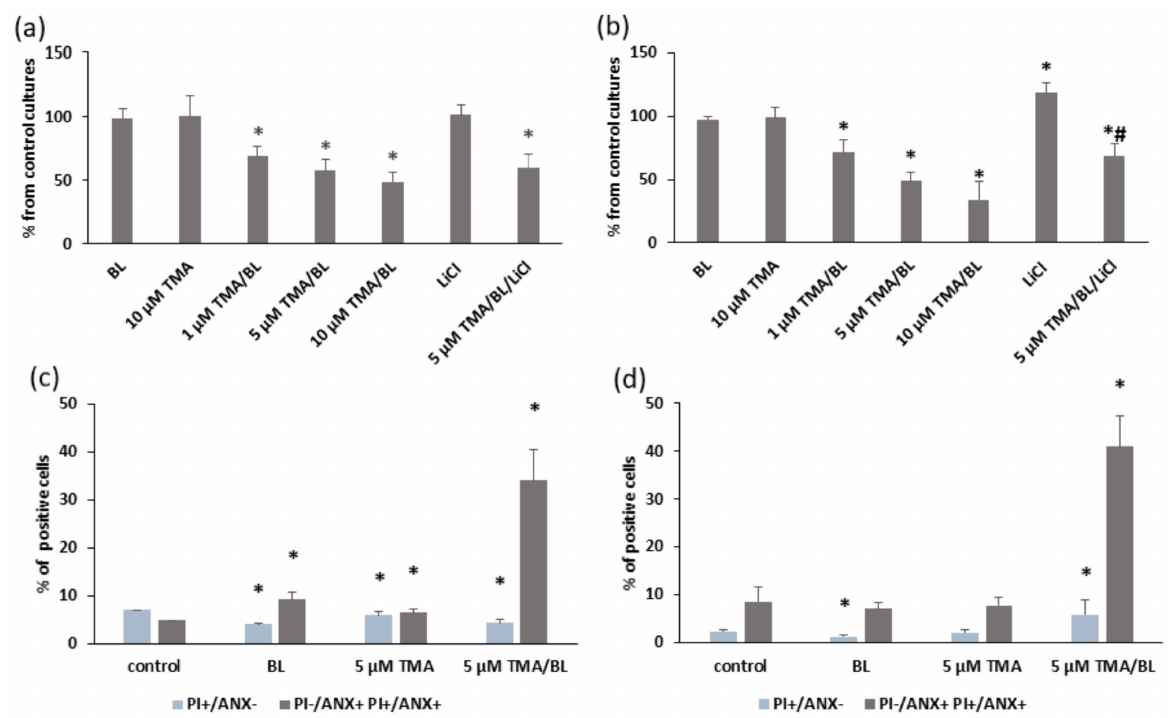
Figure 2. Cell viability ( a , b ) and apoptosis ( c , d ) determined by trypan blue staining and a FACS analysis with annexin V (ANX) and propidium iodide (PI), respectively, at 24 ( a , c ) and 48 ( b , d ) h after the treatment with TMA, blue light (BL) (2 J/cm 2 ), and 1-mM LiCl. Data were obtained from 3 experiments carried out in triplicate and reported as mean ± SD. * = p < 0.05 vs. untreated cultures taken as the control and # = p < 0.05 vs. 5- µ M TMA/BL-treated cells, Student’s t